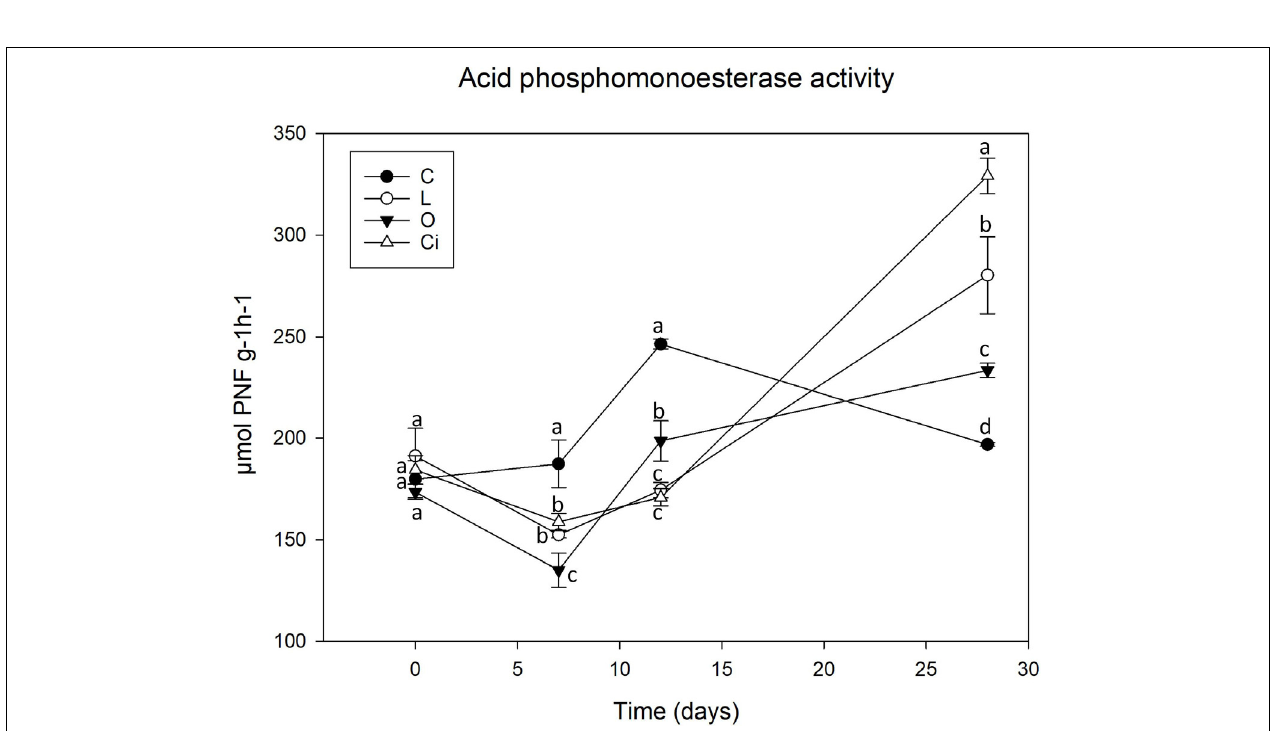
Frontiers in Plant Science |